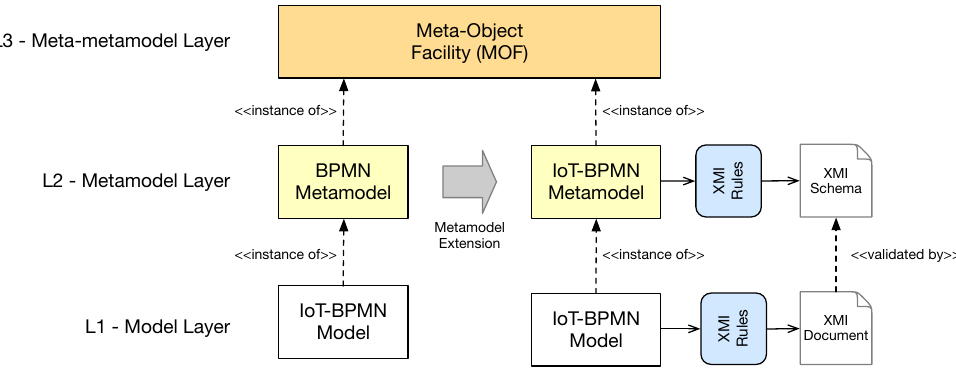
Figure 5. MDA-based Extension